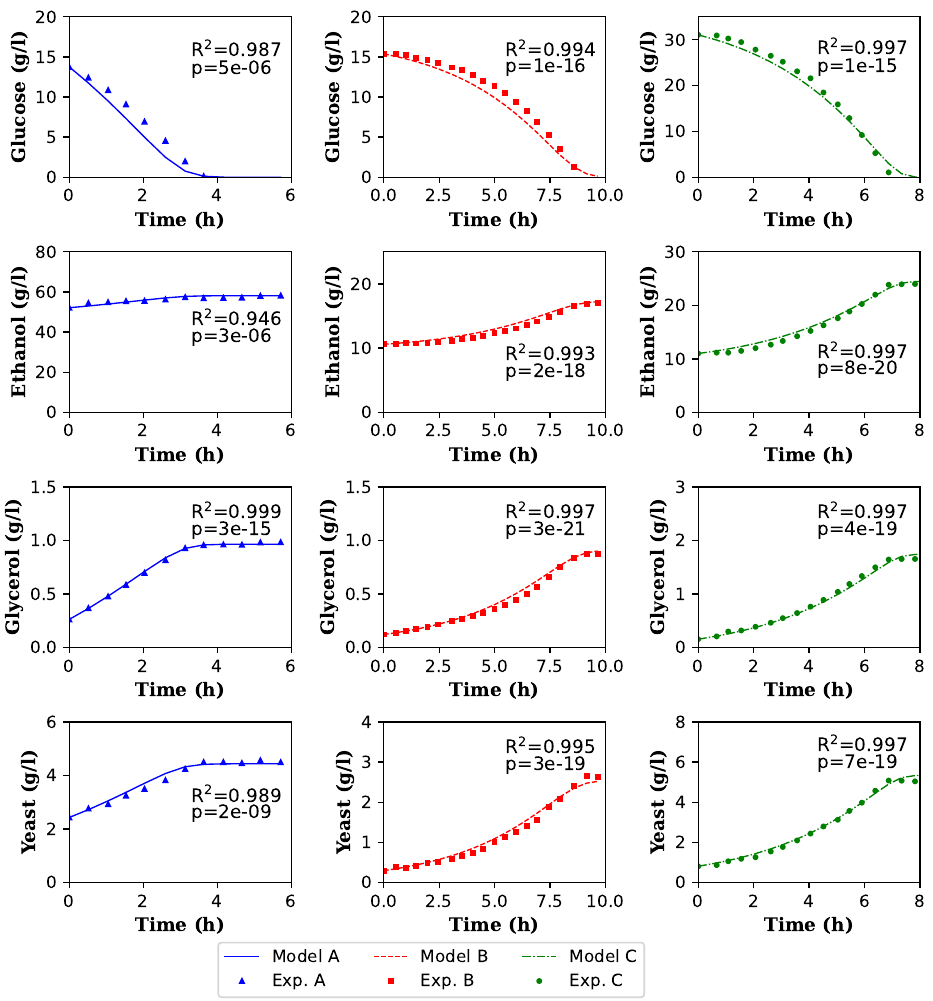
Figure 5. Yeast activity simulation under complete anaerobic conditions. Comparison between model output and experimental